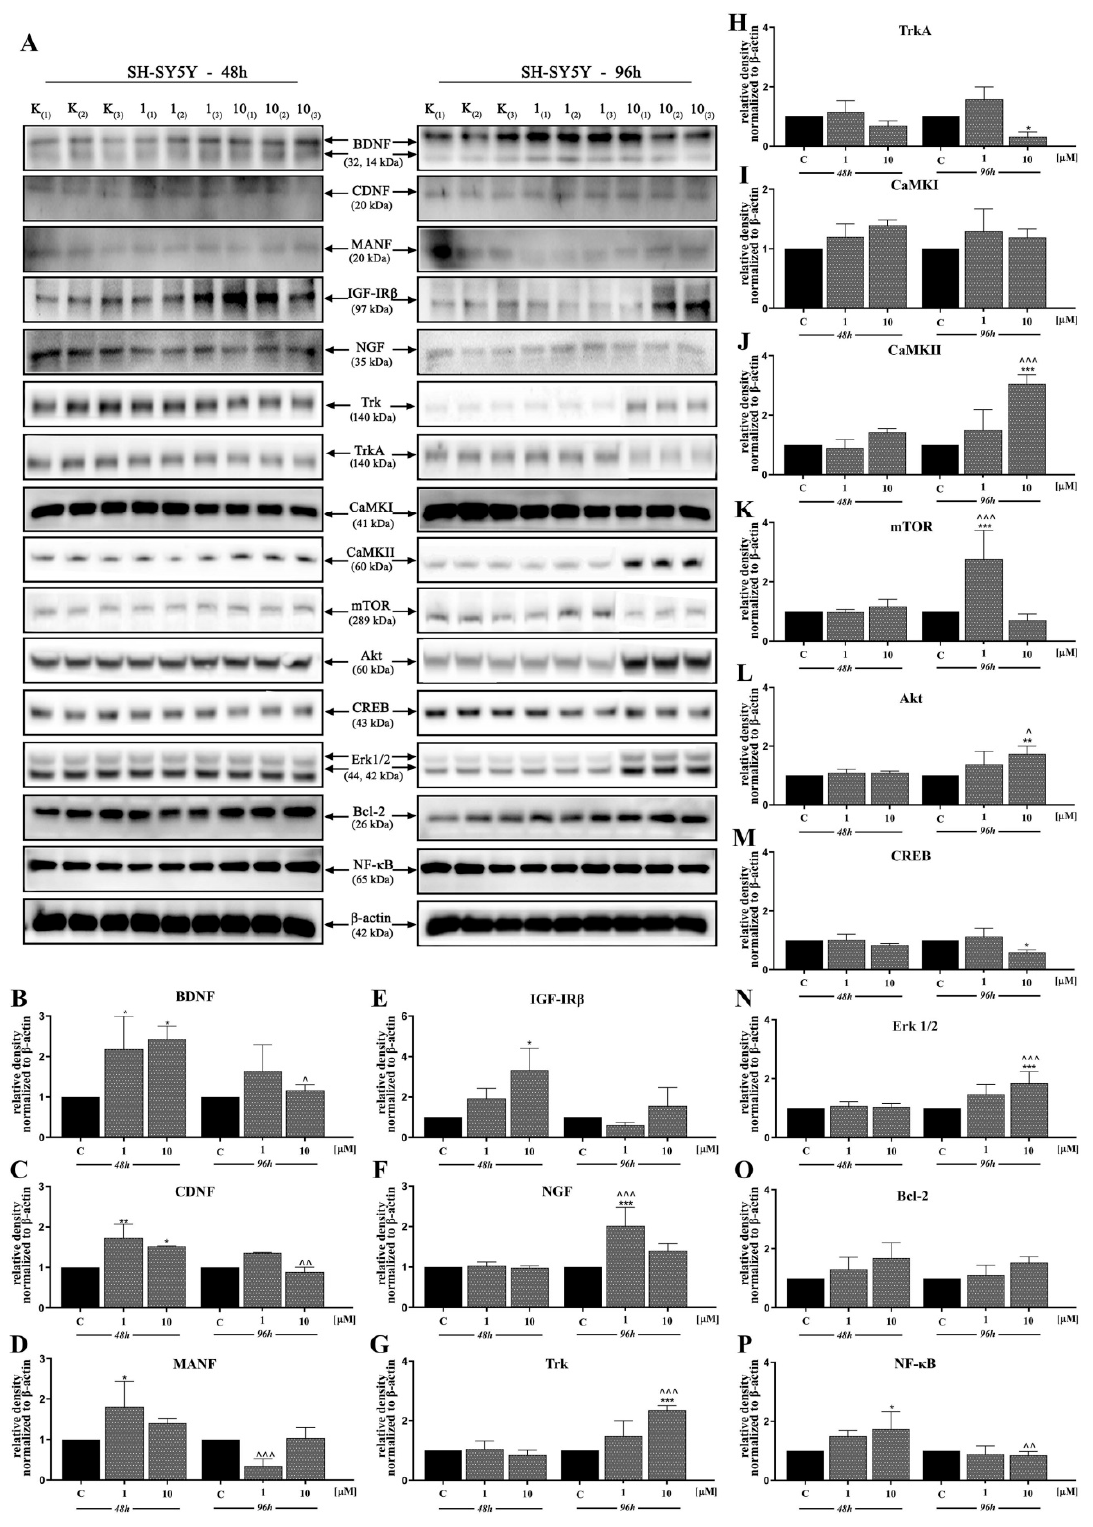
Figure 5. D2AAK1-mediated effect on SH-SY5Y cellular protein pathways. Cells were treated for 48 and 96 h with two different concentrations of D2AAK1. Representative immunoblots are shown ( A ). Western Blot analysis of BDNF ( B ), CDNF ( C ), MANF ( D ), IGF- Ir β ( E ), NGF ( F ), Trk ( G ), TrkA ( H ), CaMKI ( I ), CaMKII ( J ), mTOR ( K ), Akt ( L ), CREB ( M ), Erk 1/2 ( N ), Bcl-2 ( O ), NF- κ B ( P ) synthesis level was performed. Bars indicate SD, n = 3, * p < 0.05; ** p < 0.01; *** p < 0.001 when compared between the control sample, not treated with the compound and the test sample incubated with the D2AAK1; ^ p < 0.05; ^^ p < 0.01; ^^^ p < 0.001 when compared between the incubation time (48 and 96 h).